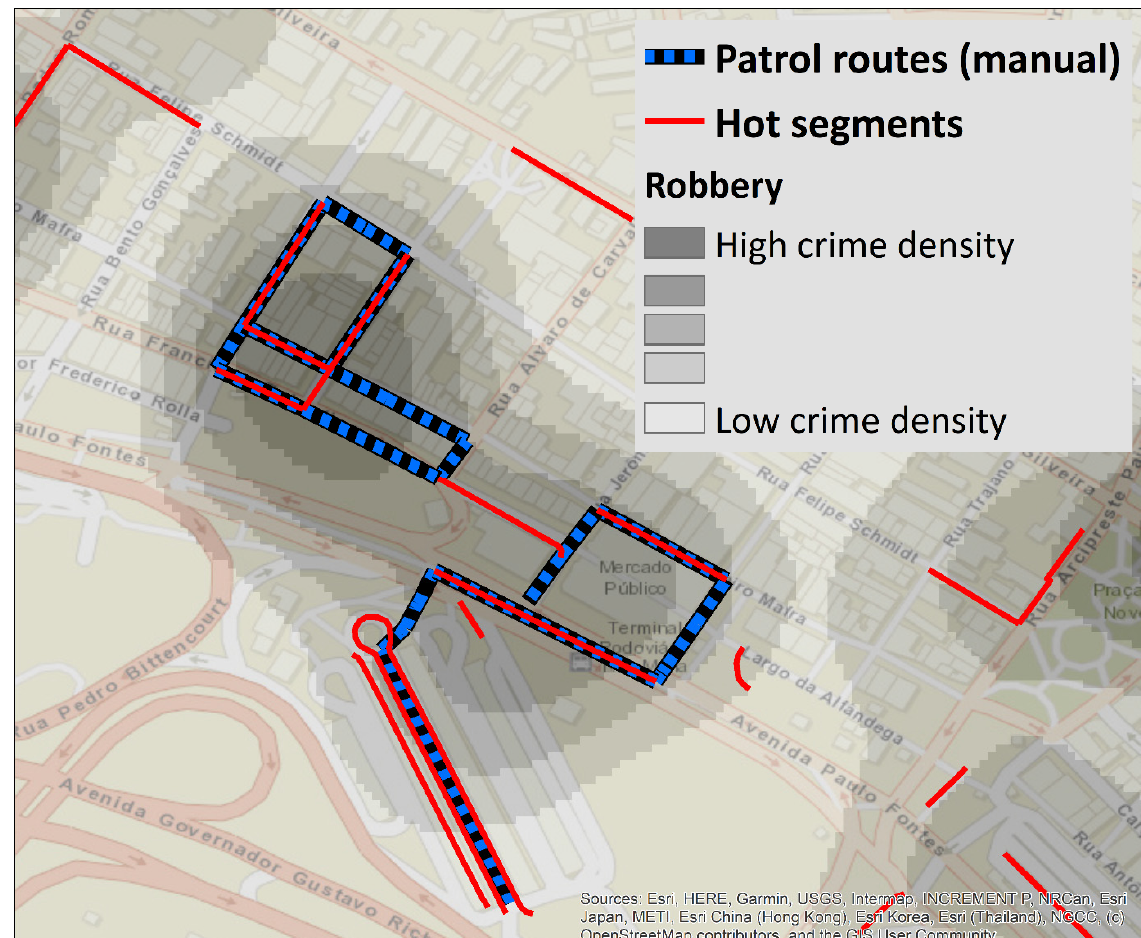
Figure 1. Hot segments and KDE hot spots in Florianópolis and two manually created patrol